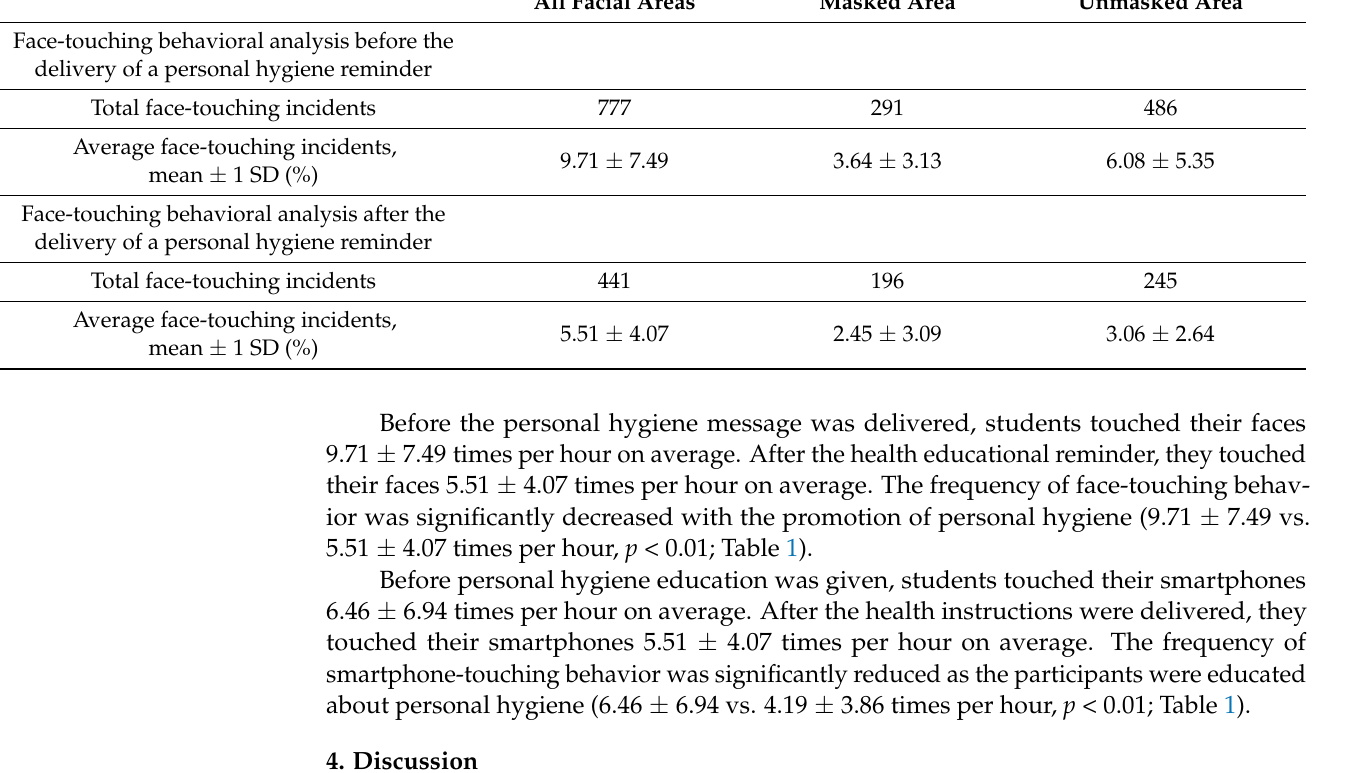
Figure 1. Face-touching behavior during COVID-19 pandemic, depicting masked and unmasked areas. Table 2. Face-touching behavioral analysis before and after the delivery of a personal hygiene reminder during the COVID-19 pandemic. All Facial Areas Masked Area Unmasked